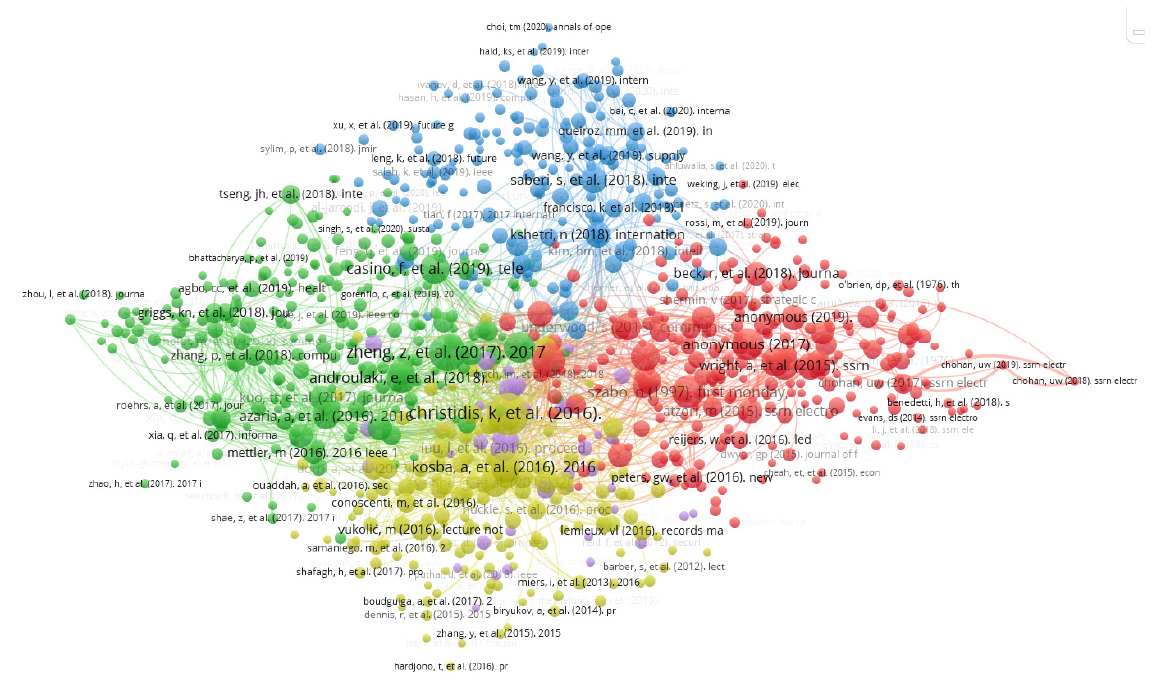
Figure 4. VOSviewer mapping of blockchain technology and smart contracts in decentralized